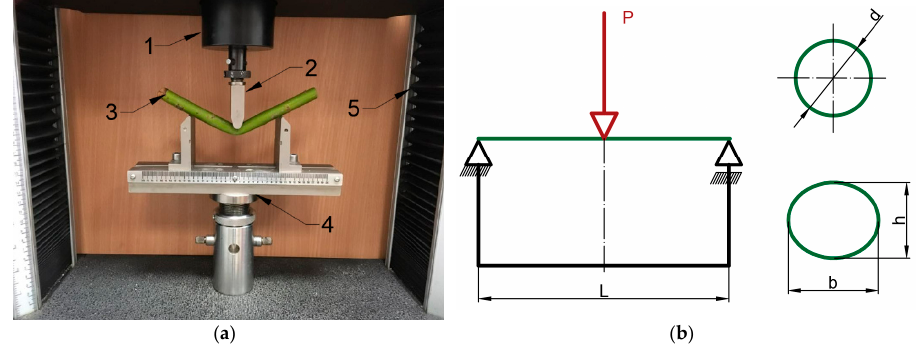
Figure 4. The measurement station for bending test: ( a ) View of the measuring instrument: 1—measuring head, 2—measuring adapter, 3—sample, 4—support, 5—guide, ( b ) Characteristic dimensions: L—length of the sample, d—diameter, h—height, b—width.